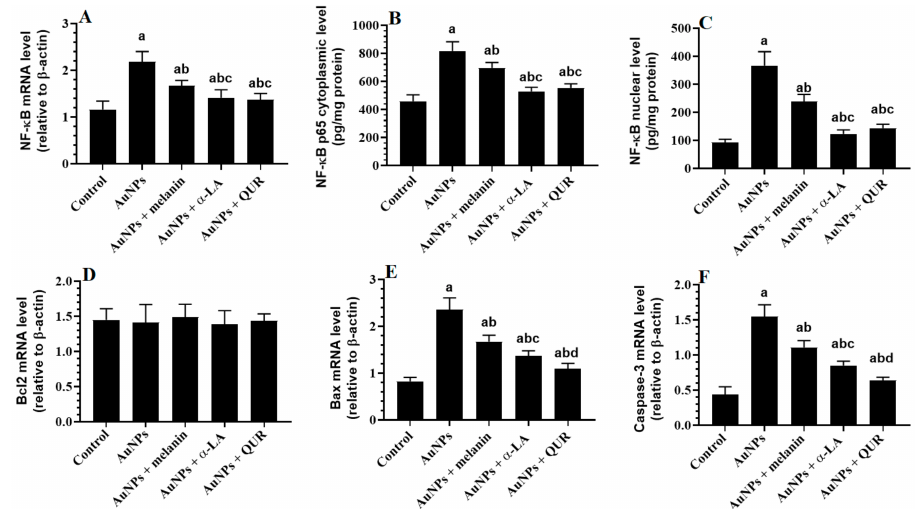
Figure 1. ( A ) Total mRNA levels, ( B ) cytoplasmic levels, and ( C ) nuclear levels of NF- κ B as measured by ELISA, as well as total mRNA levels of ( D ) Bcl2, ( E ) Bax, and ( F ) caspase-3 in the kidneys of all groups of rats. Data are given as the mean ± SD ( n = 8 animals/group)— a : vs. control rats; b : vs. AuNPs-treated rats; c : vs. AuNPs + melanin-treated rats; d : vs. AuNPs + α -LA-treated rats.